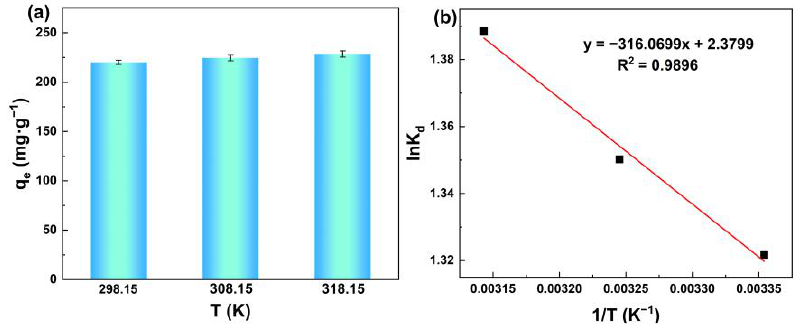
Figure 8. ( a ) Adsorption capacity of silicic acid as a function of the temperature; ( b ) Fitting diagram of adsorption thermodynamic model of the silicic acid adsorption process.